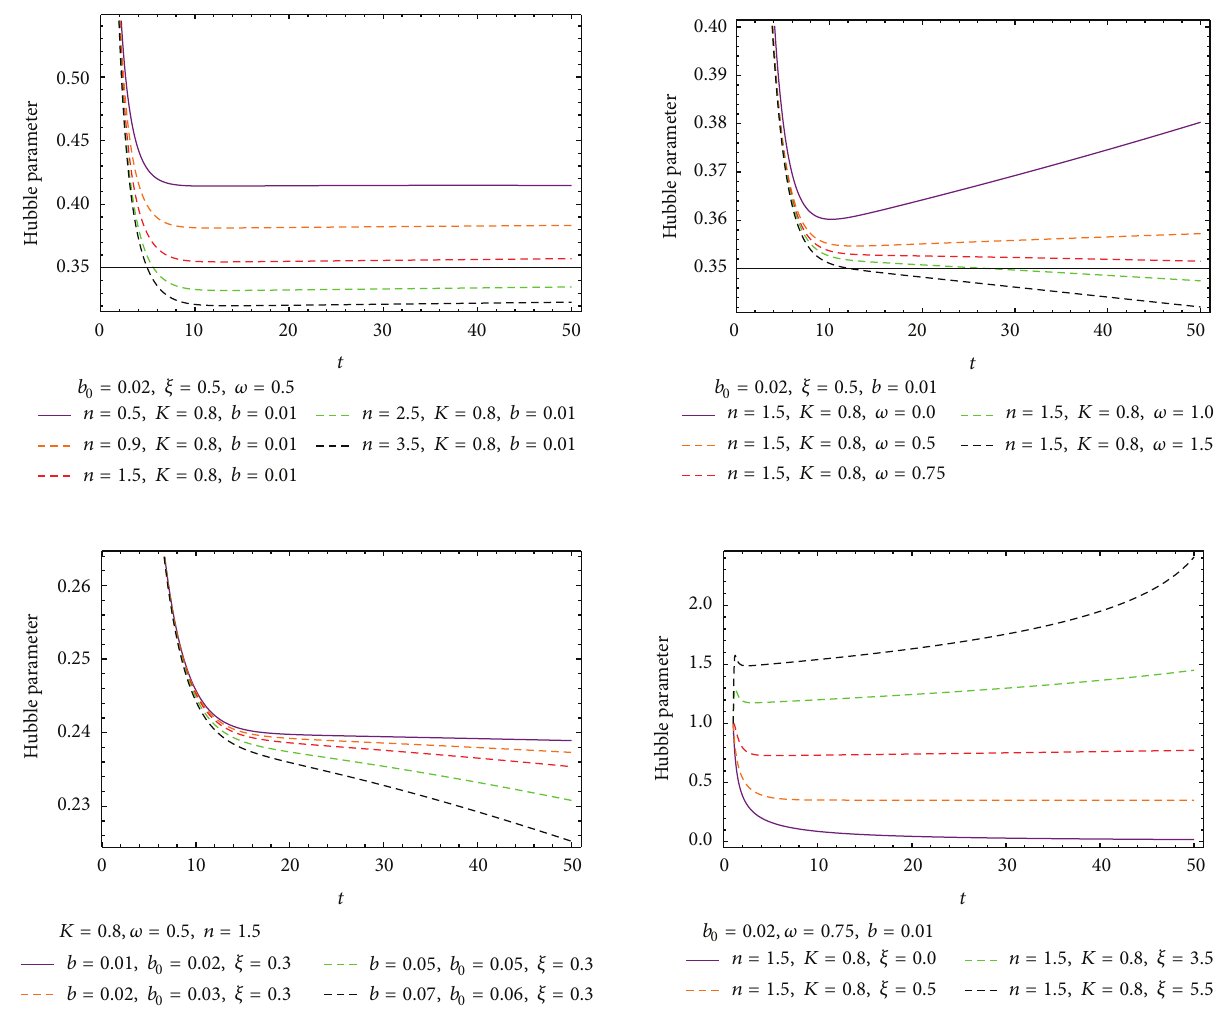
Figure 4: Behavior of Hubble parameter 𝐻 against 𝑡 for interacting barotropic fluid and viscous polytropic